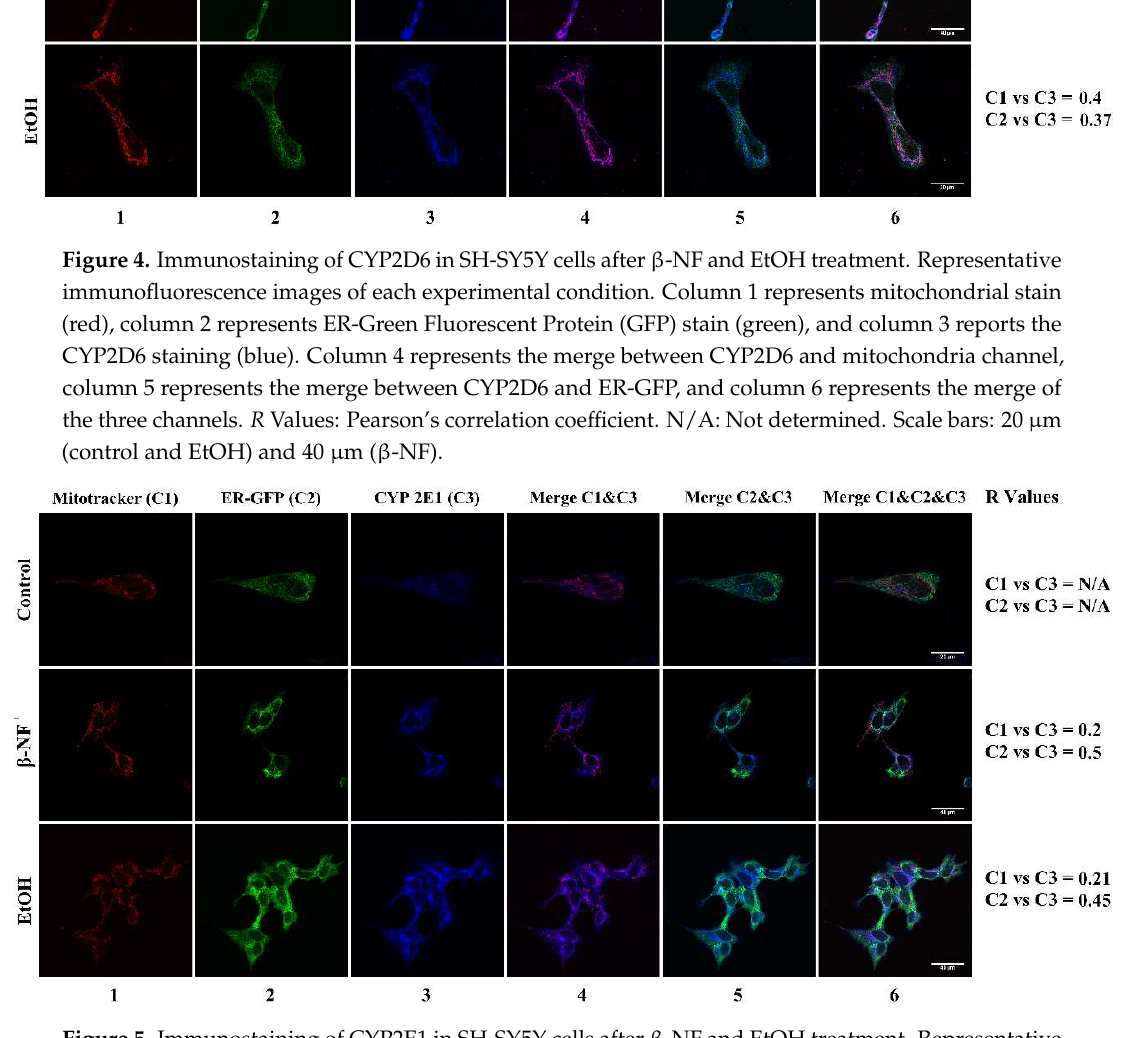
Figure 5. Immunostaining of CYP2E1 in SH-SY5Y cells after β -NF and EtOH treatment. Representative immunofluorescence images of each experimental condition. Column 1 represents mitochondrial stain (red), column 2 represents ER-Green Fluorescent Protein (GFP) stain (green), and column 3 reports the CYP2E1 staining (blue). Column 4 represents the merge between CYP2E1 and mitochondria channel, column 5 represents the merge between CYP2E1 and ER-GFP, and column 6 represents the merge of the three channels. R Values: Pearson’s correlation coefficient. N/A: Not determined. Scale bars: 20 µm (control), 40 µm (β-NF and EtOH). Fluorescent images of CYP1A1 revealed no preferential localization of this isoform at mitochondria or ER, yet the R values showed to be slightly higher in ER (Figure 6). The R values of mitochondrial localization in β-NF and EtOH treatments were 0.12 and 0.19, respectively; while the R values of ER localization were 0.23 and 0.28, respectively. Similar to CYP2D6 and 2E1, the low expression of CYP1A1 in the control condition did not allow us to calculate the R Pearson coefficient.